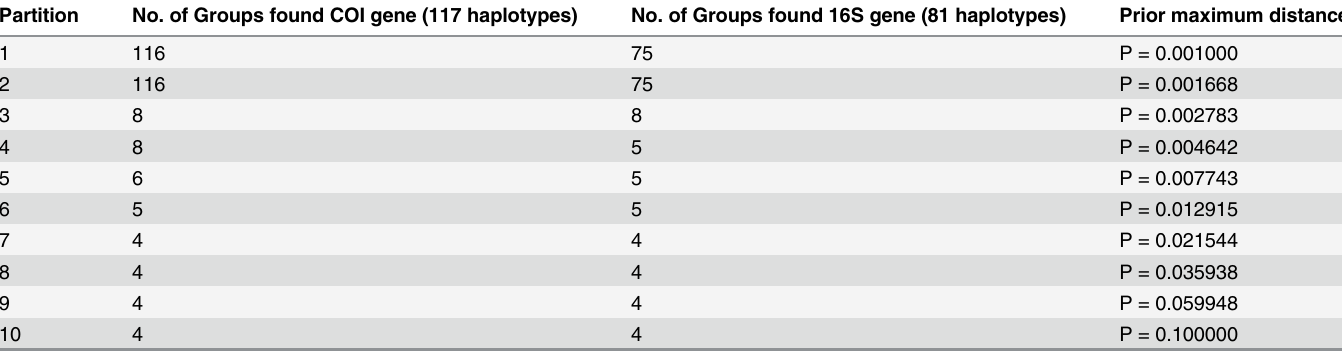
Table 3. Results of automatic barcode gap discovery analyses of distance matrices for the COI and 16S datasets. Cerion incanum haplotypes are numbered, Cerion casablancae haplotypes (from Indian Key) are prefixed with the letter C.